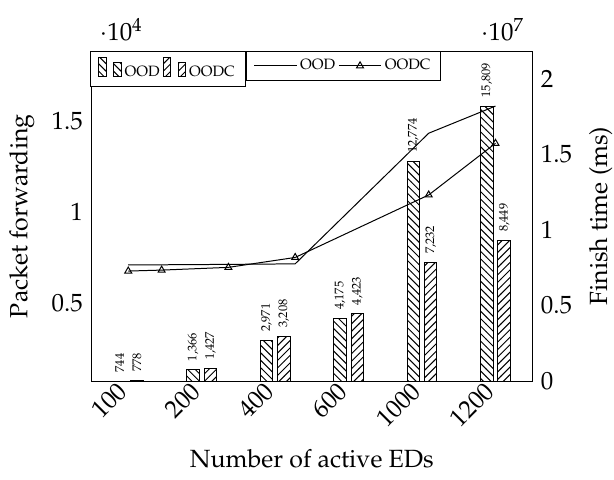
Figure 11. Performance evaluations between OD and OODC.